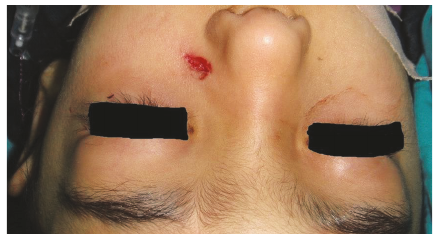
Figure 4: Photograph of the patient after